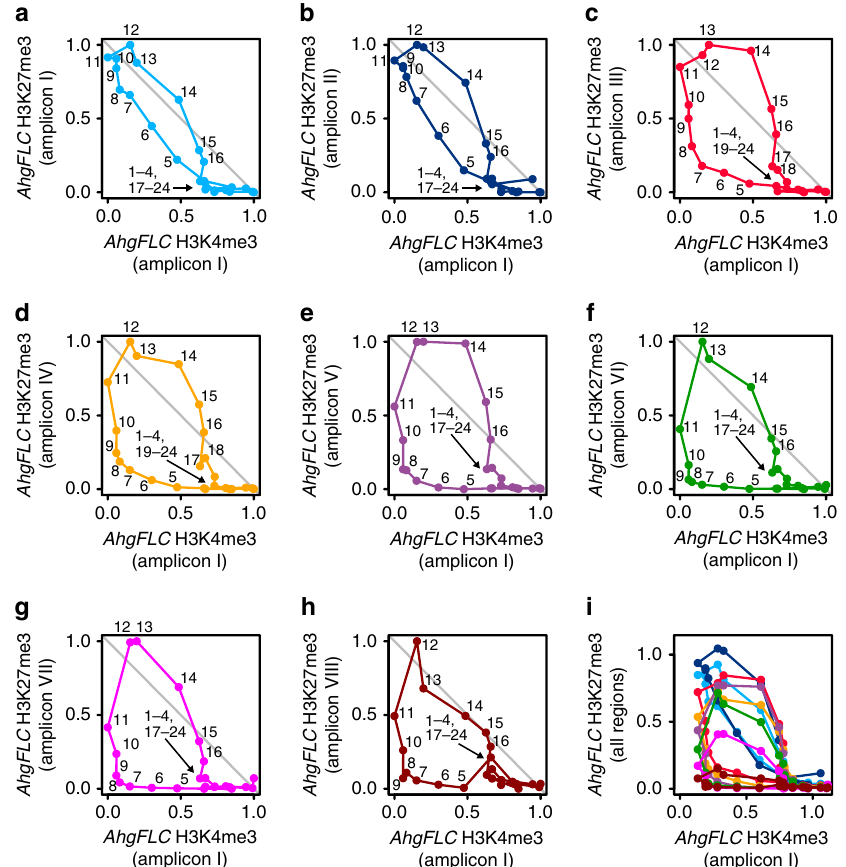
Fig. 3 Phase differences between the seasonal dynamics of AhgFLC H3K27me3 and H3K4me3 for the fi rst year measurement. a – h Lissajous curves, i.e. time-series trajectories of two sets of cyclical values, delineated by plotting AhgFLC H3K4me3 at amplicon I on the horizontal axis and H3K27me3 at amplicon I ( a ), amplicon II ( b ), amplicon III ( c ), amplicon IV ( d ), amplicon V ( e ), amplicon VI ( f ), amplicon VII ( g ), and amplicon VIII ( h ) on the vertical axis. AhgFLC H3K27me3 and H3K4me3 levels are shown as relative values, setting the minimum level to 0 and the maximum level to 1 in a – h . The numbers next to the data points are chronological ordinals (1: 25 September 2012, 24: 10 September 2013). i Lissajous curves drawn using the absolute values for all tested regions. The colour code corresponds to that in Fig. 1a. Data are normalised against AhgSTM (H3K27me3) and AhgACT2 (H3K4me3) and shown as the means of four biological replicates. Source data are provided as a Source Data fi